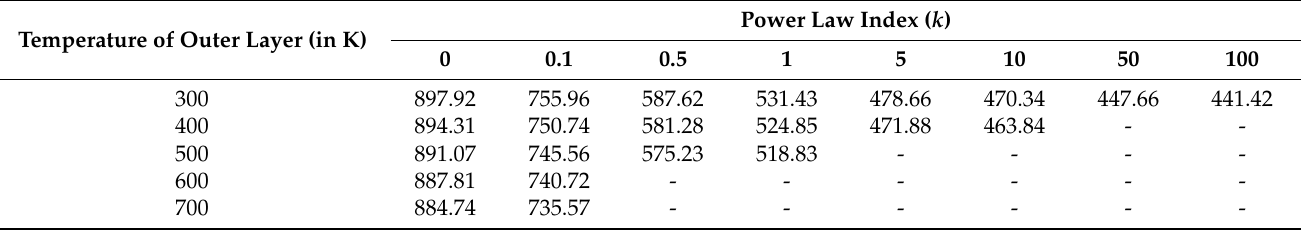
Table 9. Critical buckling temperature (in K) of an aluminum/silicon carbide FGM shell under linear temperature rise for different material composition in re-entry vehicle nose structures.